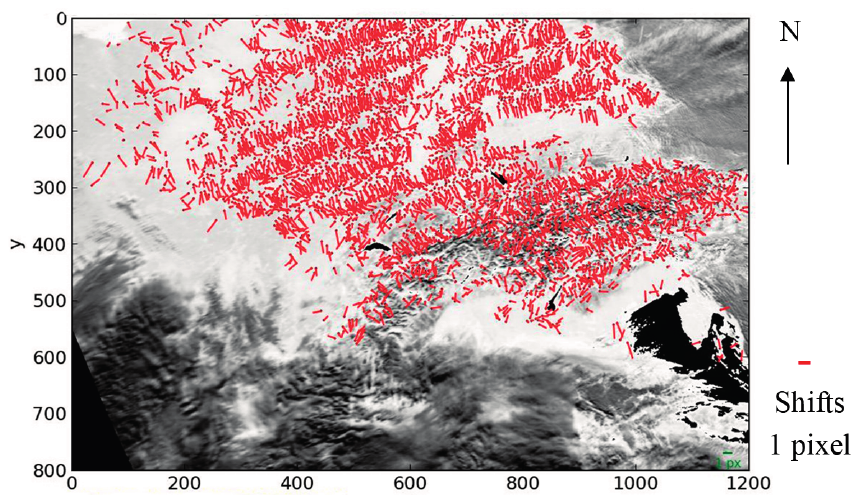
Figure 10. Image space shifts obtained from matching of Metop-A and NOAA-18 images acquired on 26 December 2008. The axes denote the image